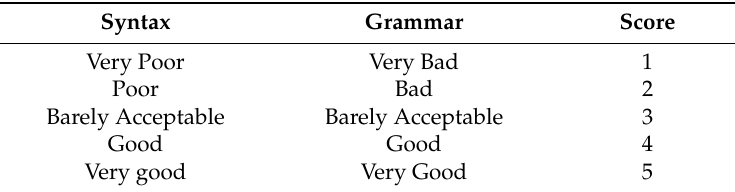
Table 3. Readability Scoring Criteria. Higher score indicates stronger readability. Score is from 1 to 5 and higher scores are